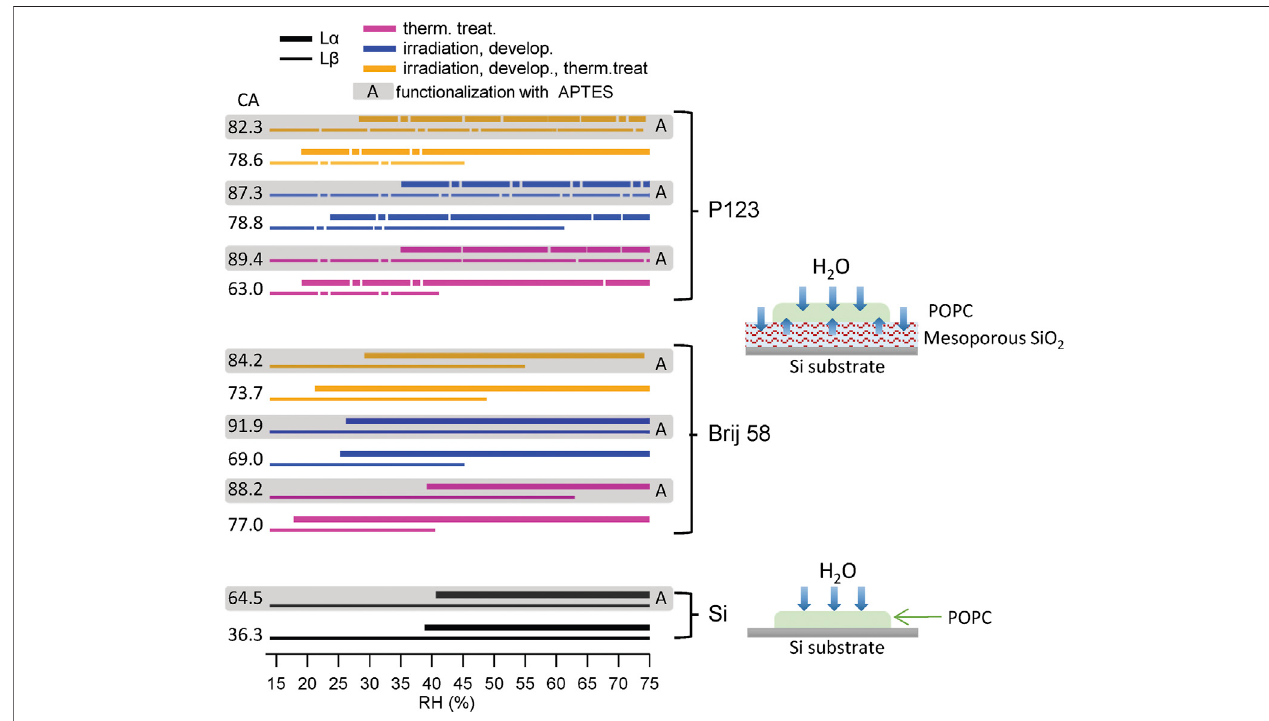
FIGURE 5 | Summary of the RH range of L α and L β phases for all samples and sketch of the hydration pathway. Black lines represent POPC deposited on silicon substrates (bottompanel) ,continuouslinesshowthemesoporous fi lmspreparedusingtheBrij58surfactant (middlepanel) anddashedlinesshowthe fi lmsprepared with P123 (top panel) . Thicker lines correspond to L α phases, and thinner ones correspond to L β . The shadowed areas with the letter A indicate the samples functionalized with APTES. The pink colors (bottom lines) represent thermally treated samples, the blue ones (middle lines) represent irradiated and developed ones,andtheyellowones (toplines) representirradiated,developed,andthermallytreatedones.TheCAvalueisreportedbesidethecorrespondingsample.Schemes of the hydration pathway of the lipid membrane deposited on Si and mesoporous thin fi lms are, respectively, shown beside the corresponding substrates.